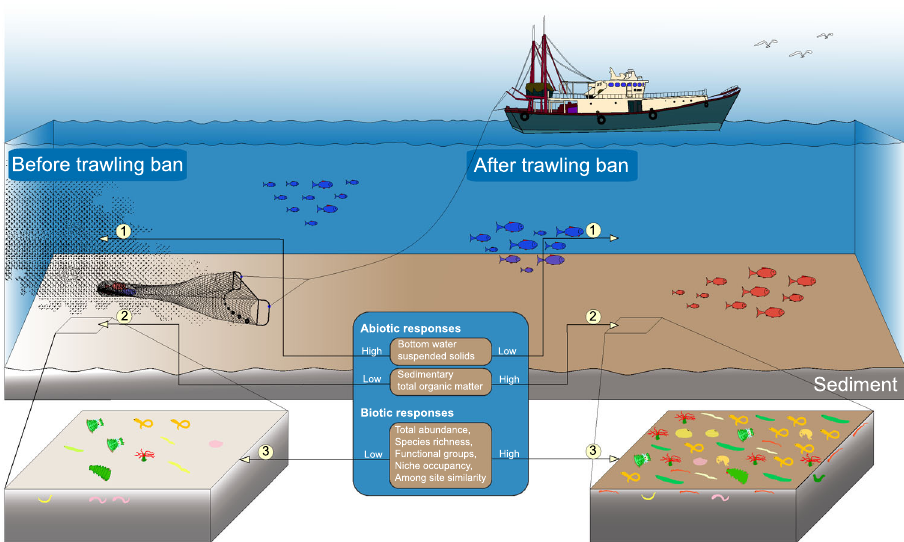
Fig. 1 An infographic showing the abiotic and biotic responses to the territory-wide trawl ban in Hong Kong waters. Abiotic responses to the trawl ban include: (1) lower bottom water suspended-solid loads, (2) higher sedimentary organic contents; and Biotic responses include: (3) higher site-based abundance, species richness, functional diversity, niche occupancy and among-site similarity of